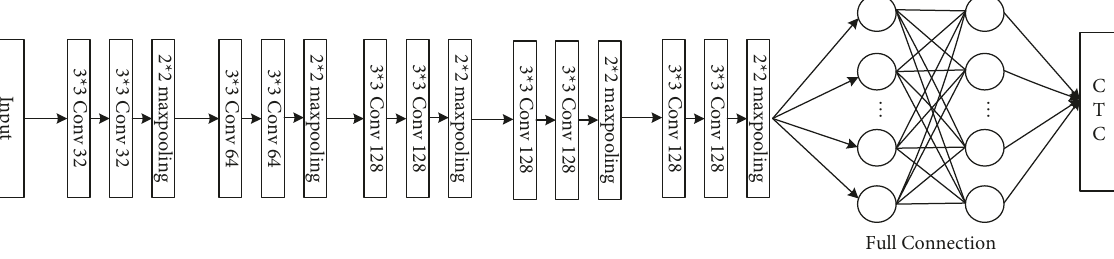
Figure 1: The structure of the DCNN-CTC acoustic model.